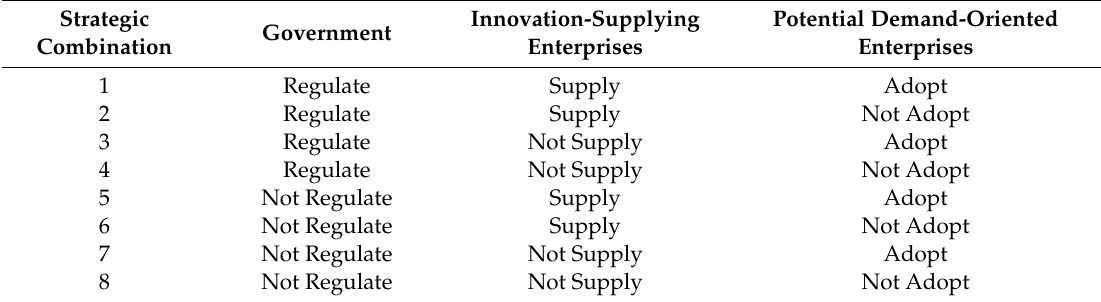
Table 1. The strategic combination for the tripartite evolutionary game among the government, innovation-supplying enterprises and potential demand-oriented